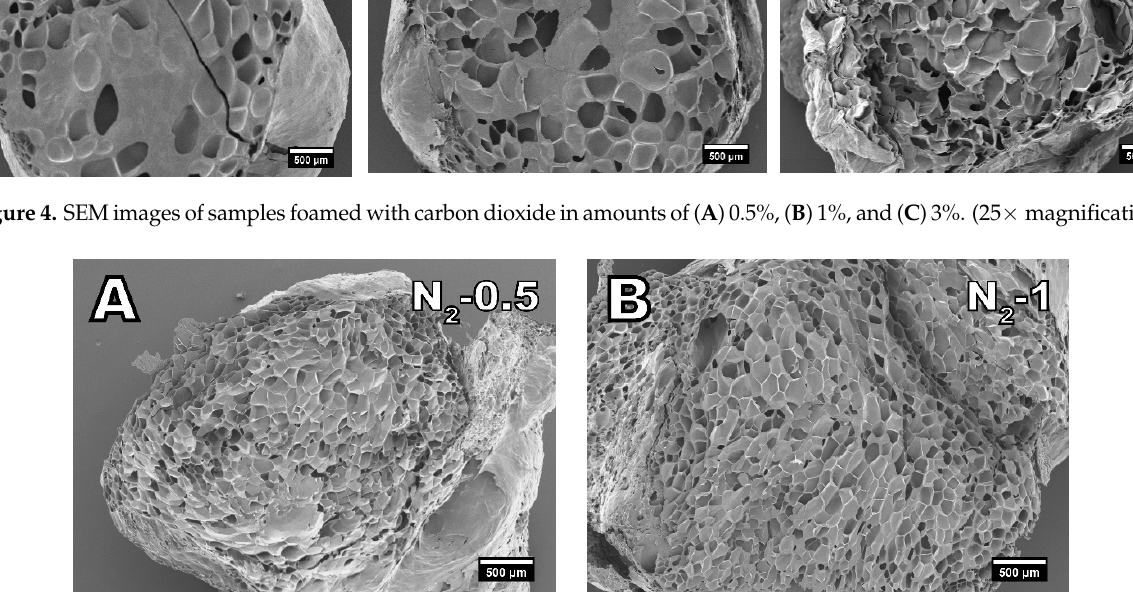
Figure 5. SEM images of samples foamed with nitrogen in amounts of ( A ) 0.5% and ( B ) 1%. (25× magnification).